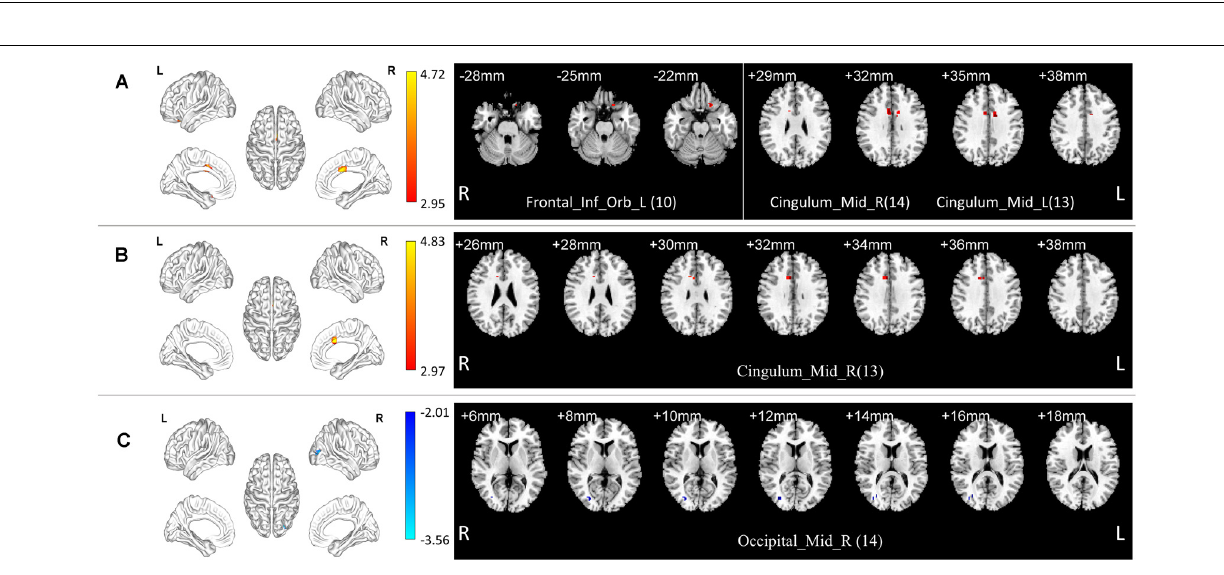
FIGURE 2 | Local functional change pattern of aMCI group. (A) In the normal band, compared with the HC group, the aMCI group showed increased fALFF in the left orbital part of the inferior frontal gyrus, bilateral median cingulate, and paracingulate gyri (Two-tailed t -test; FDR p < 0.001, k > 10 voxels). (B) In the slow-5 band, compared with the HC group, the aMCI group showed increased fALFF in the right median cingulate and paracingulate gyri (Two-tailed t -test; FDR p < 0.001, k > 10 voxels). (C) In the normal band, compared with the Obj-SCD group, the aMCI group showed decreased fALFF in the right middle occipital gyrus (Two-tailed t -test; FDR p < 0.017, k > 10 voxels). The numbers in brackets are voxels of significant clusters. Labels of significant clusters are defined with the AAL (Anatomical Automatic Labeling) atlas. Abbreviation: aMCI, amnestic